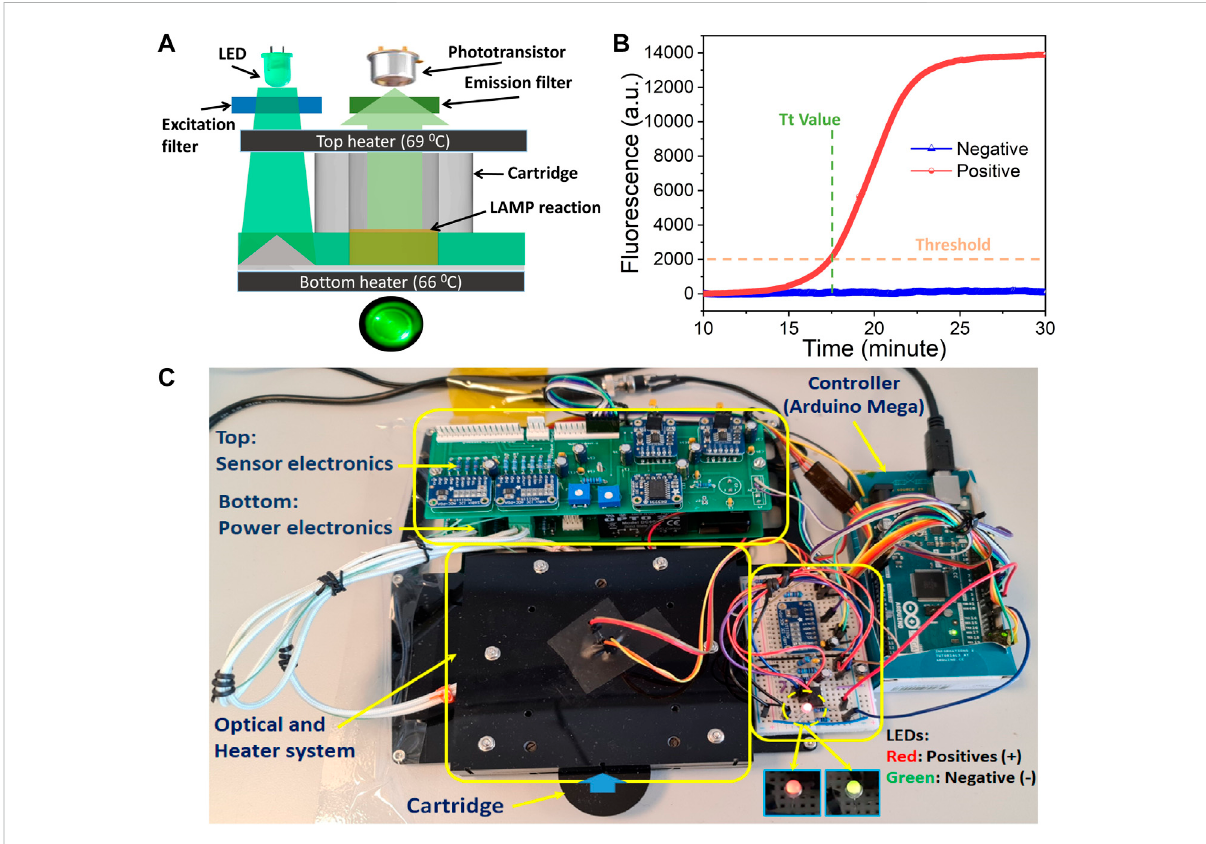
FIGURE 1 fPOC system: (A) fl uorescence detection and operation principle of the system, and (B) fl uorescence signal intensity with control negative and positive samples, and (C) a fPOC